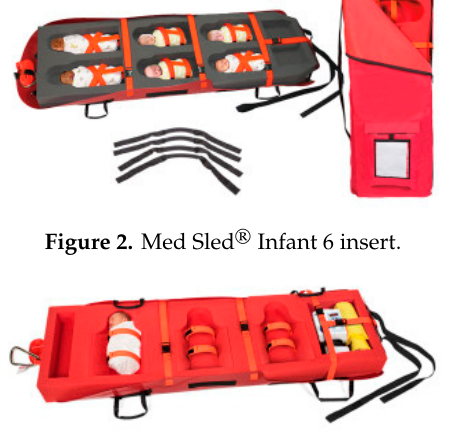
Figure 3. Med Sled ® infant insert that can hold up to three infants .